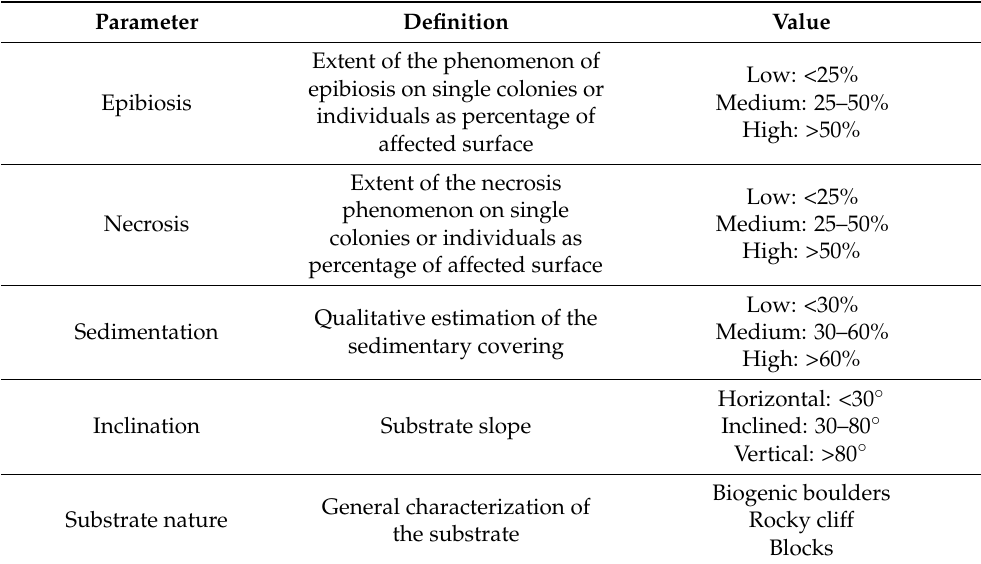
Table 1. Parameters considered for the habitat characterization, with relative